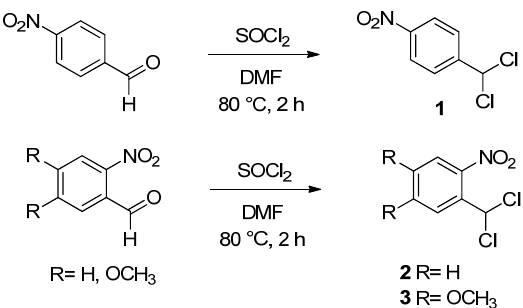
Table 1. Both electron-withdrawing and electron-donating substituents on the phenyl ring of the N -tosylimines were suitable for this reaction. 1 H-NMR spectral studies identified the aziridines 5a – g as trans or cis isomers by their coupling constant. Two distinct doublets appeared in 3.39–4.60 ppm region with J = 4.3–4.7 Hz or J = 7.3–9.4 Hz, each of the signals corresponding to one proton. The